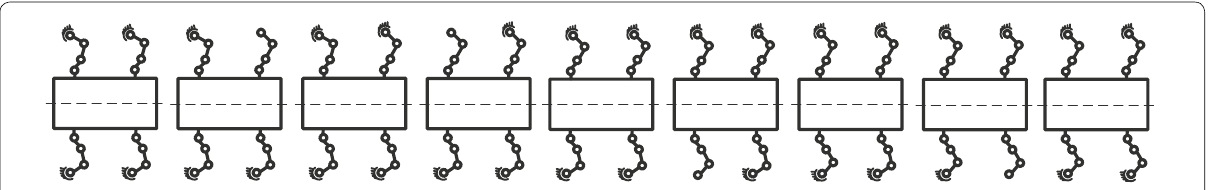
Figure 4 Sequence of equivalent mechanisms in one cycle of creeping gait